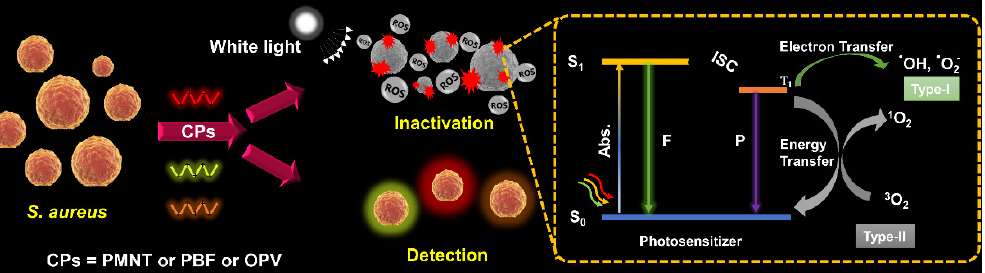
Figure 17. Schematic diagram of PMNT, PBF, and OPV for diagnosis and photodynamic killing of S. aureus . Reprinted with permission from Ref. [62]. Copyright 2022 American Chemical Society.